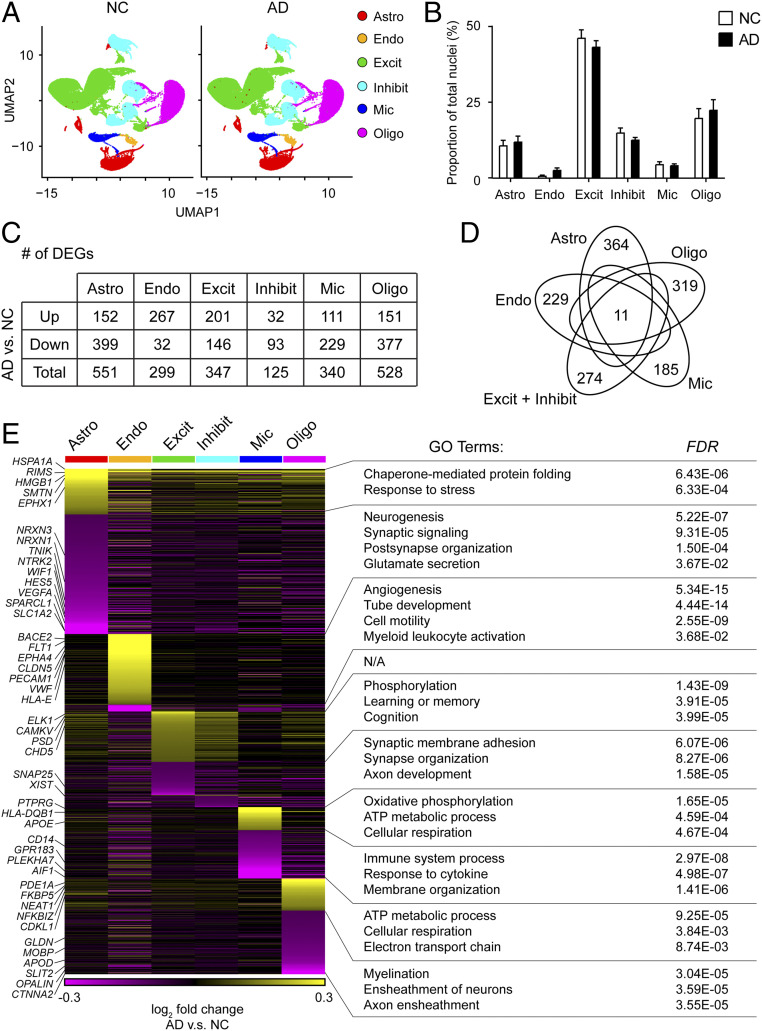
Dysregulated molecular pathways in AD according to cell type-specific transcriptomic changes. UMAP plots (A) and bar plot (B) showing the proportions of the six major cell types found in the AD and NC prefrontal cortical samples. (C and D) AD-associated transcriptomic changes were highly cell type-specific. (C) Numbers of DEGs between AD and NC samples within each cell type (adjusted P < 0.1, log2 fold change ≥ 0.1 or ≤ −0.1). Down: down-regulated; Up: up-regulated. (D) Venn diagram showing the 11 coregulated DEGs among all six cell types. Also shown are the numbers of DEGs specific to each cell type. (E) The cell type-specific transcriptomic changes in AD were associated with distinct molecular pathways. Heatmap showing the expression changes of DEGs in all six cell types in AD samples. Specific GO terms are listed at Right. Astro: astrocytes, Endo: endothelial cells, Excit: excitatory neurons, Inhibit: inhibitory neurons, Mic: microglia, and Oligo: oligodendrocytes. All data are mean ± SEM. See also SI Appendix, Figs. S2 and S4 and Table S3.